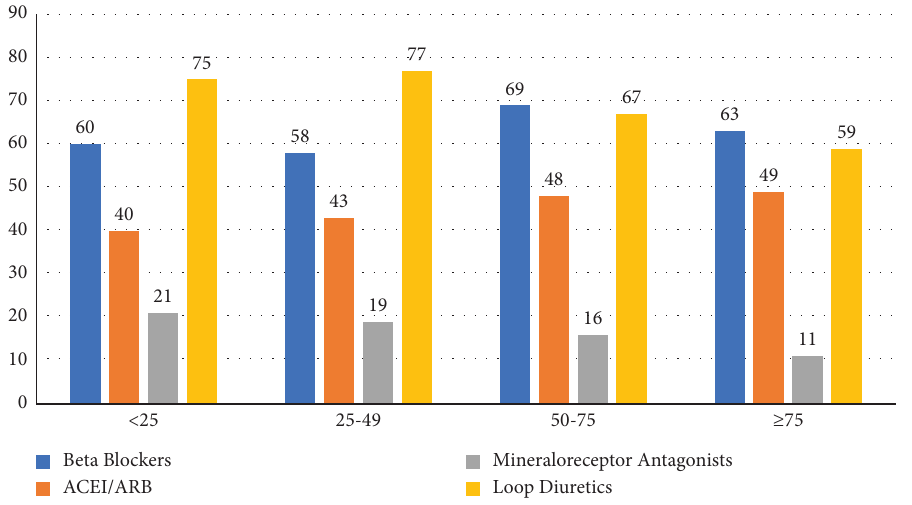
Figure 1: Tirty-days heart failure medications in the four KCCQ Table 1: Baseline characteristics of the study cohort.